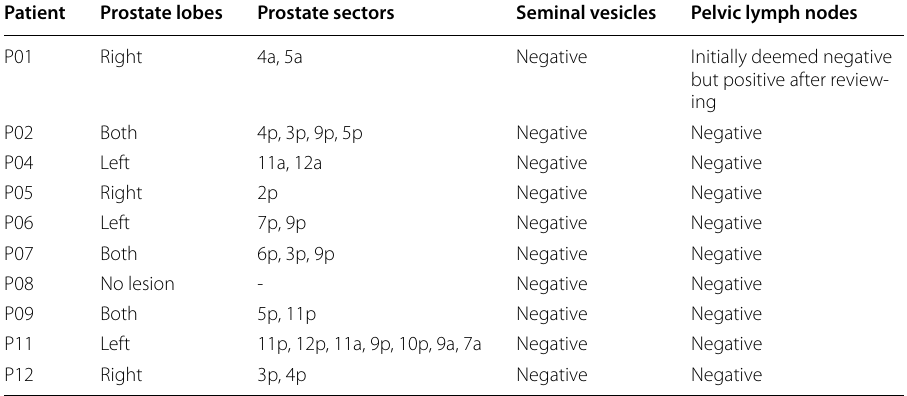
Table 5 Pre-surgery MRI prostate lesions localization, seminal vesicles and pelvic lymph nodes involvement